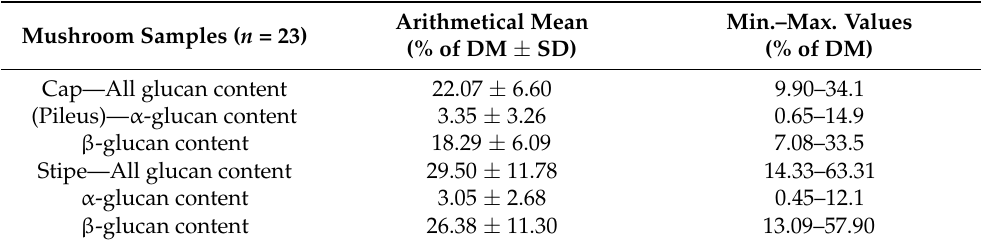
Table 5. Average glucan (all, α , and β ) contents in caps and stipes of 23 mushroom samples and the distribution of data (minimum and maximum values based on data of [32]).